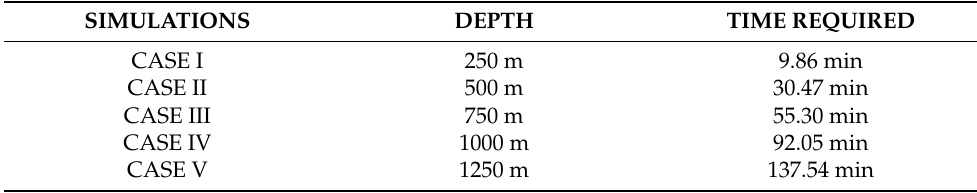
Figure 9. CPU time estimation as function of sea depth. Table 1. Computational cost estimation as function of sea depth.